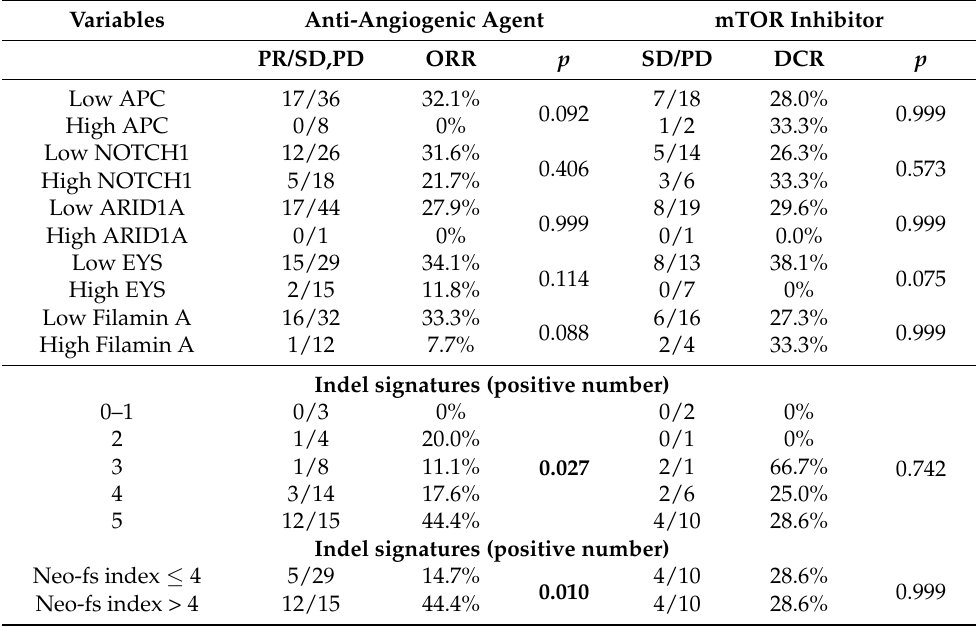
Table 4. Association between immunohistochemical expression and the response to